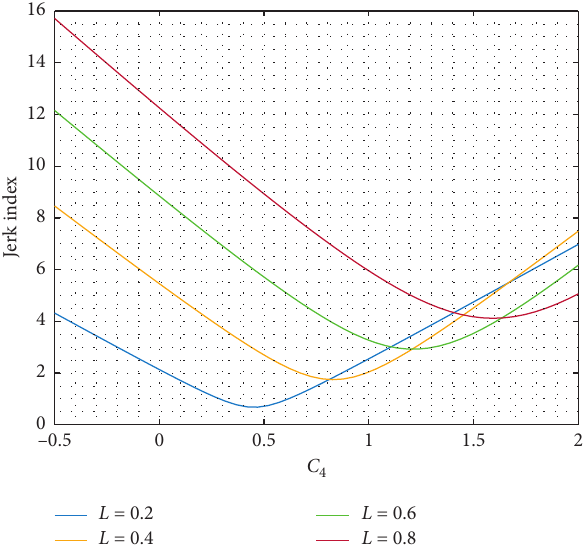
Figure 7: Jerk index versus the fourth input constant ( C different cable lengths with the standard maneuver time.